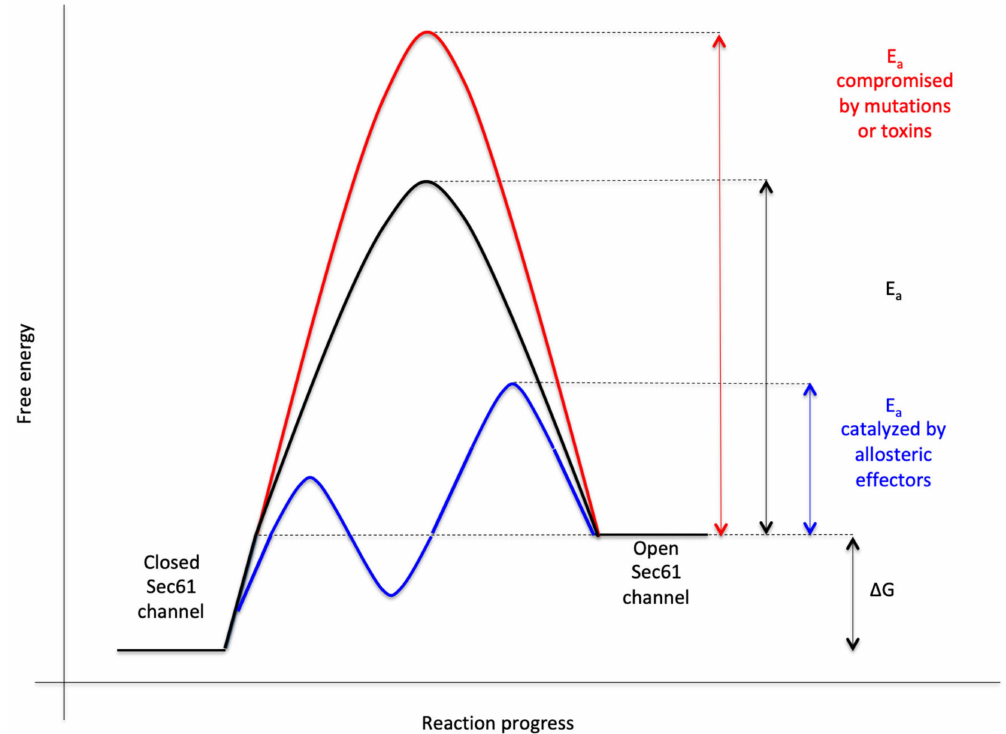
Figure 3. Energetics and kinetics of Sec61 channel gating. In our view, the TRAP − or Sec62/Sec63 +/ − BiP-mediated Sec61 channel gating is best considered in analogy to an enzyme-catalysed reaction. Accordingly, TRAP, Sec62, Sec63 or BiP reduce the energetic barrier for full channel opening, which can apparently be reinforced by Sec61 channel inhibitors, such as cyclic heptadepsipeptides (such as CAM741) or certain eeyarestatins (such as ES24). At least in the case of ES24, binding of the inhibitor within the channel pore arrests the channel in a partially open state (termed “foot in the door”), which maybe identical with the primed state and is compatible with Ca 2+ -efflux but not with full channel opening for protein translocation. TRAP and BiP contribute to full channel opening by direct interaction with ER luminal loops 5 and 7, respectively, of Sec61 α (see below). SEC61A1 mutations can increase the energy barrier for channel opening per se (V67G, V85D, and Q92R mutation) or indirectly, such as by interfering with BiP binding (Y344H mutation). Notably, all these effects are precursor specific because the amino-terminal SPs are either efficient or inefficient in driving Sec61 channel opening. Typical for an enzyme-catalysed reaction, BiP can also support efficient gating of the Sec61 channel to the closed state, i.e., the reverse